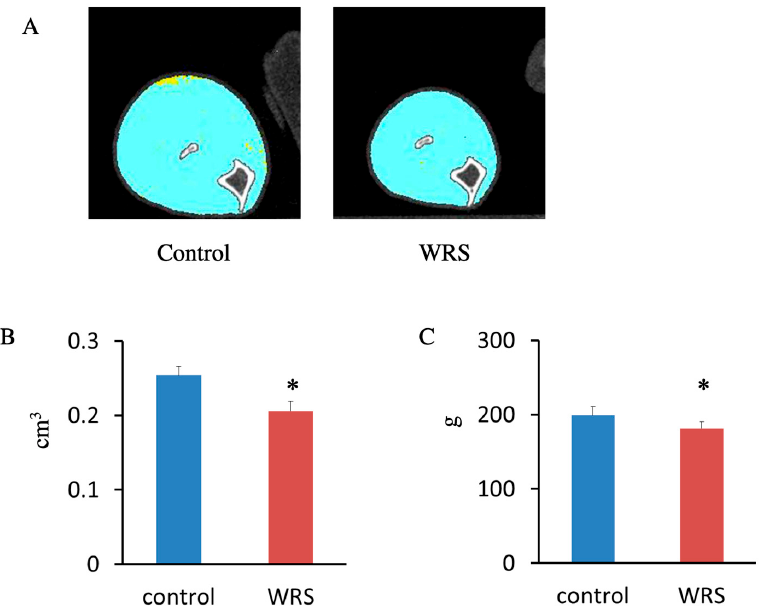
Figure 2. Cross-sectional evaluation of hind limb and muscle strength testing. ( A ) Hind limb muscle size was evaluated via computed tomography. ( B ) The size of the hind limb muscle was significantly decreased in the WRS group. ( C ) Grip strength in the WRS group was significantly lower than that in the control group. The sample size was n = 8 for the control and WRS groups. *: p < 0.05.